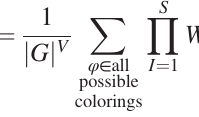
ε is the chirality of the (cid:2) ! (cid:2) ! (cid:2) ! (cid:2) ! ; 23 ; 34 ; 45 Þ(cid:2) . The